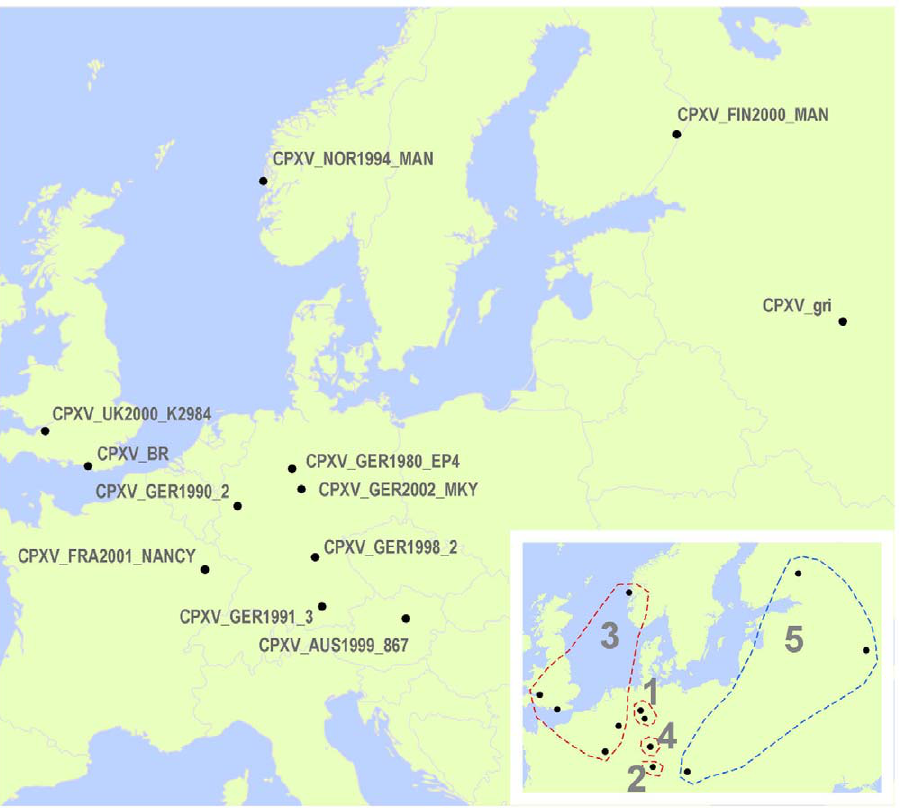
Figure 2. Map of CPXV isolate origins. The place of origin for each CPXV isolate is designated on the map. The inset shows CPXV isolates divided into five distinct clusters corresponding to those in Figure 1 and grouped by dashed lines.